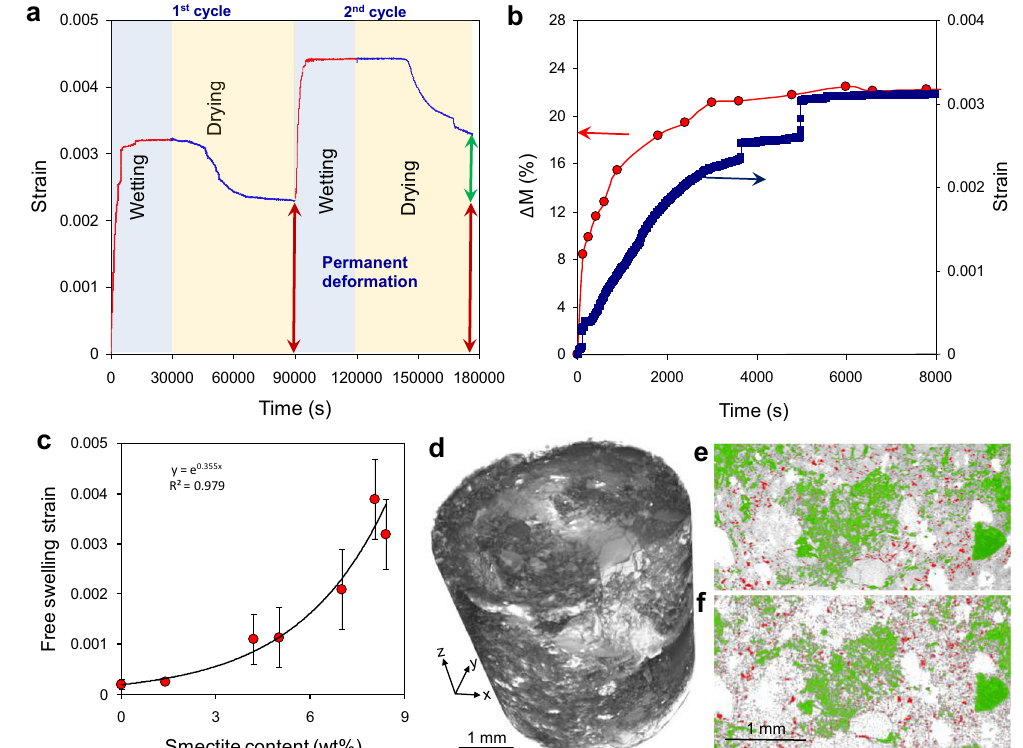
Fig. 3 Hydric expansion of Copan tuff stone (Type 2). a Free swelling strain during two wetting/drying cycles. Note the residual strain after the fi rst cycle marked by the red arrow and its increase after the second cycle marked by the green arrow (up to a fi nal residual strain of 0.0033). b Time evolution of the water absorption and free swelling strain. c Variation of free swelling strain with smectite content (error bars represent stdev, N = 3). d 3D µ-CT image of Copan stone; 2D section of the stone sample in ( d ) before ( e ) and after ( f ) water saturation. The green and red colors mark the areas of connected and non-connected porosity,